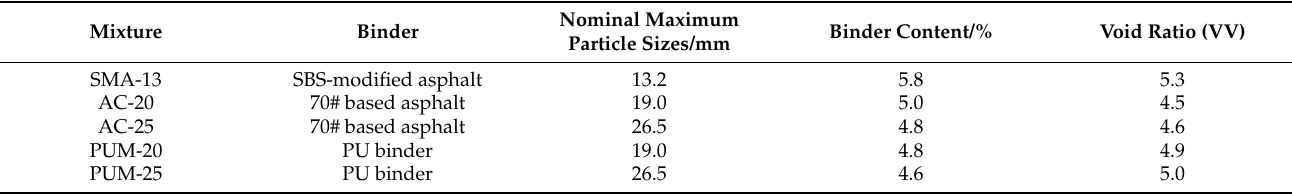
Figure 1. Mineral aggregate gradation of the mixture. Table 2. The composition design results for various mixtures.